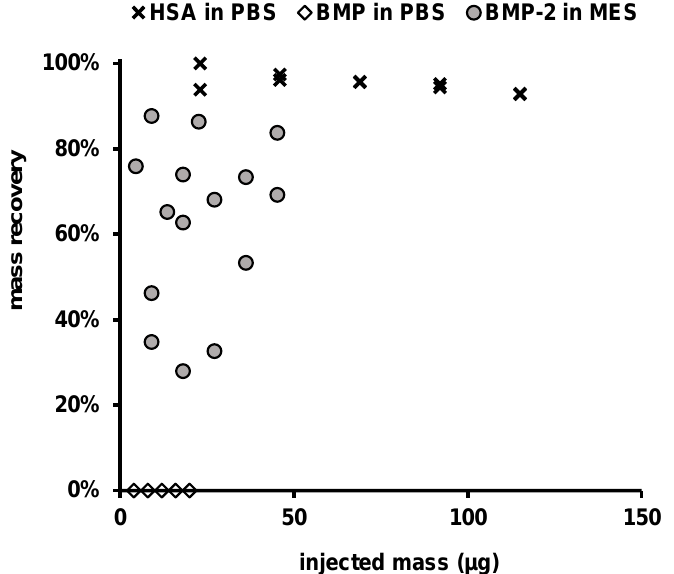
Figure 8. HSA and BMP-2 recovery (dRI detector of AF4 system) for different injected masses.